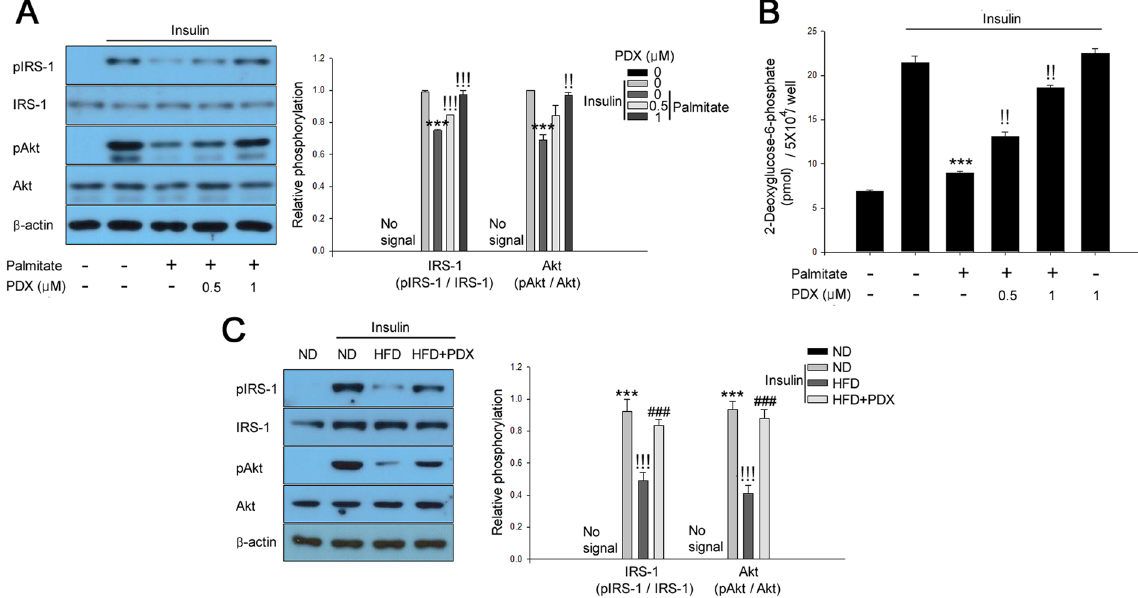
Figure 1. PDX improves insulin resistance in differentiated C2C12 cells and skeletal muscle of mice. ( A ) Western blot analysis of phosphorylation of IRS-1 and Akt and ( B ) 2-deoxyglucose uptake in C2C12 myocytes in the presence of 200 μ M palmitate and PDX (0–1 μ M) for 24 hr. Human Insulin (10 nM) stimulates IRS-1 and Akt for 3 min. ( C ) Western blot analysis of IRS-1 and Akt phosphorylation in soleus skeletal muscle from HFD-fed mice treated with PDX (five animals per treatment group). Means ± SEM were calculated from three independent experiments. *** P < 0.001 when compared to levels in control or ND treatment. !!! P < 0.001 and !! P < 0.01 when compared to palmitate or insulin injected ND treatment. ### P < 0.001 when compared to insulin-injected HFD